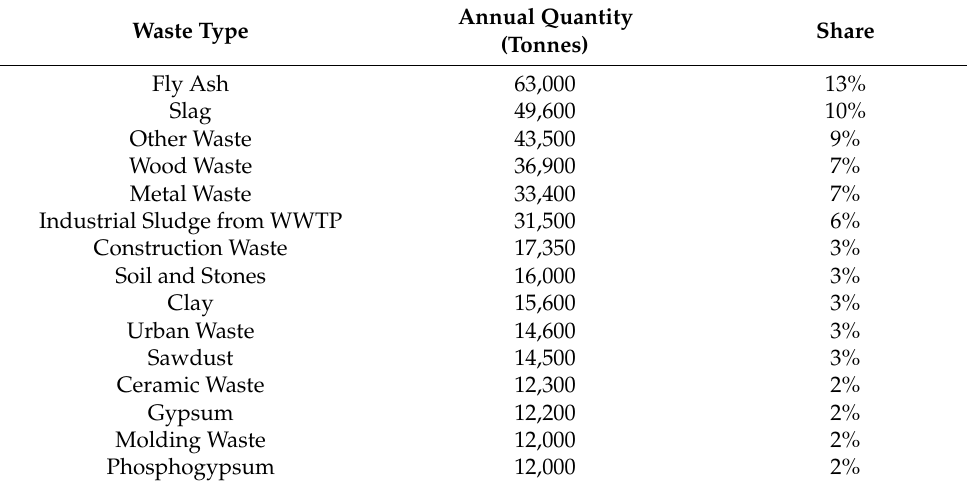
Table 1. Bulgarian Participants Waste Type